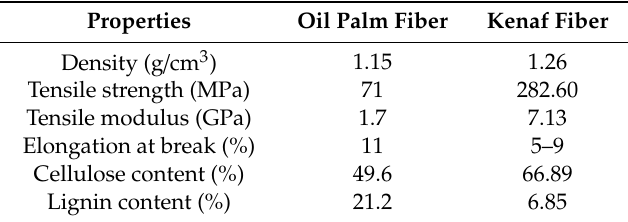
Table 1. Oil palm fiber and kenaf properties [21,22].